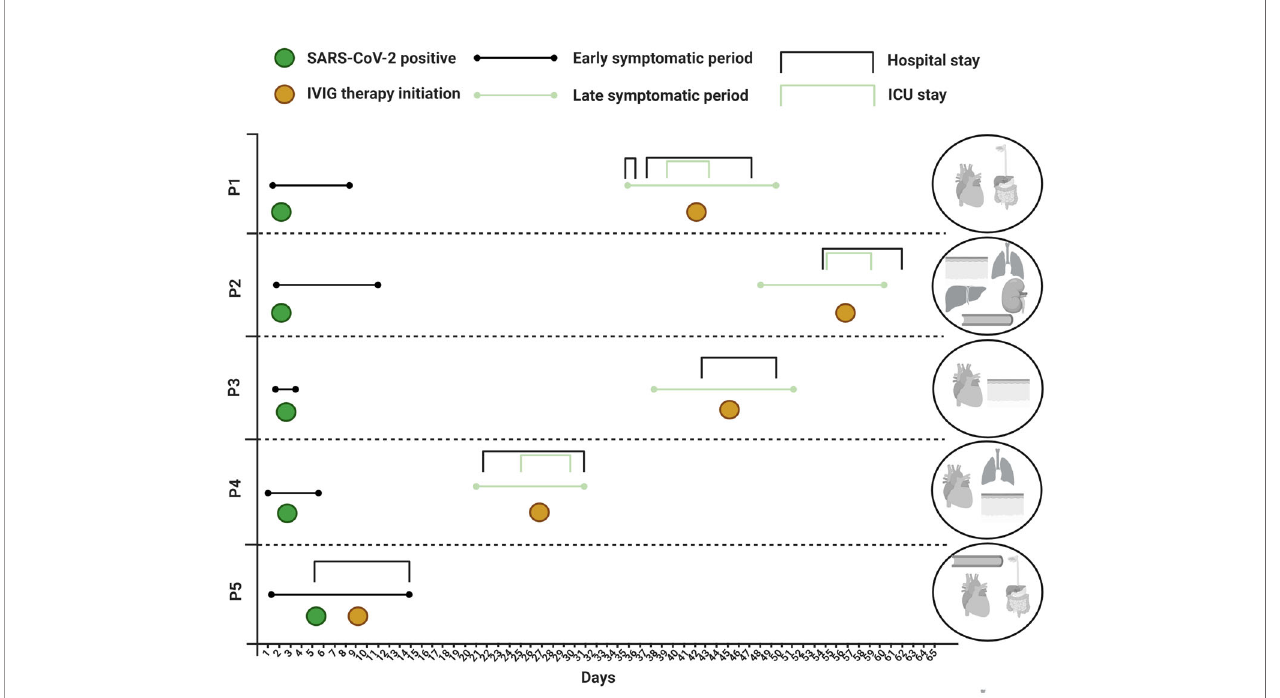
FIGURE 1 | Disease course and organ manifestations. ICU, intensive care unit; IVIG, intravenous immunoglobulin; SARS-CoV-2, severe acute respiratory syndrome coronavirus